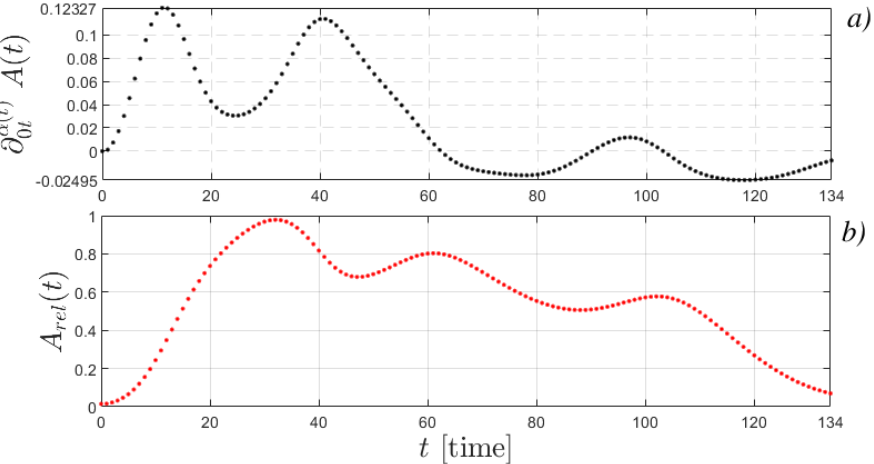
Figure 13. Dependence in time: ( a ) on the value of the fractional derivative; ( b ) model curve (12) for Example